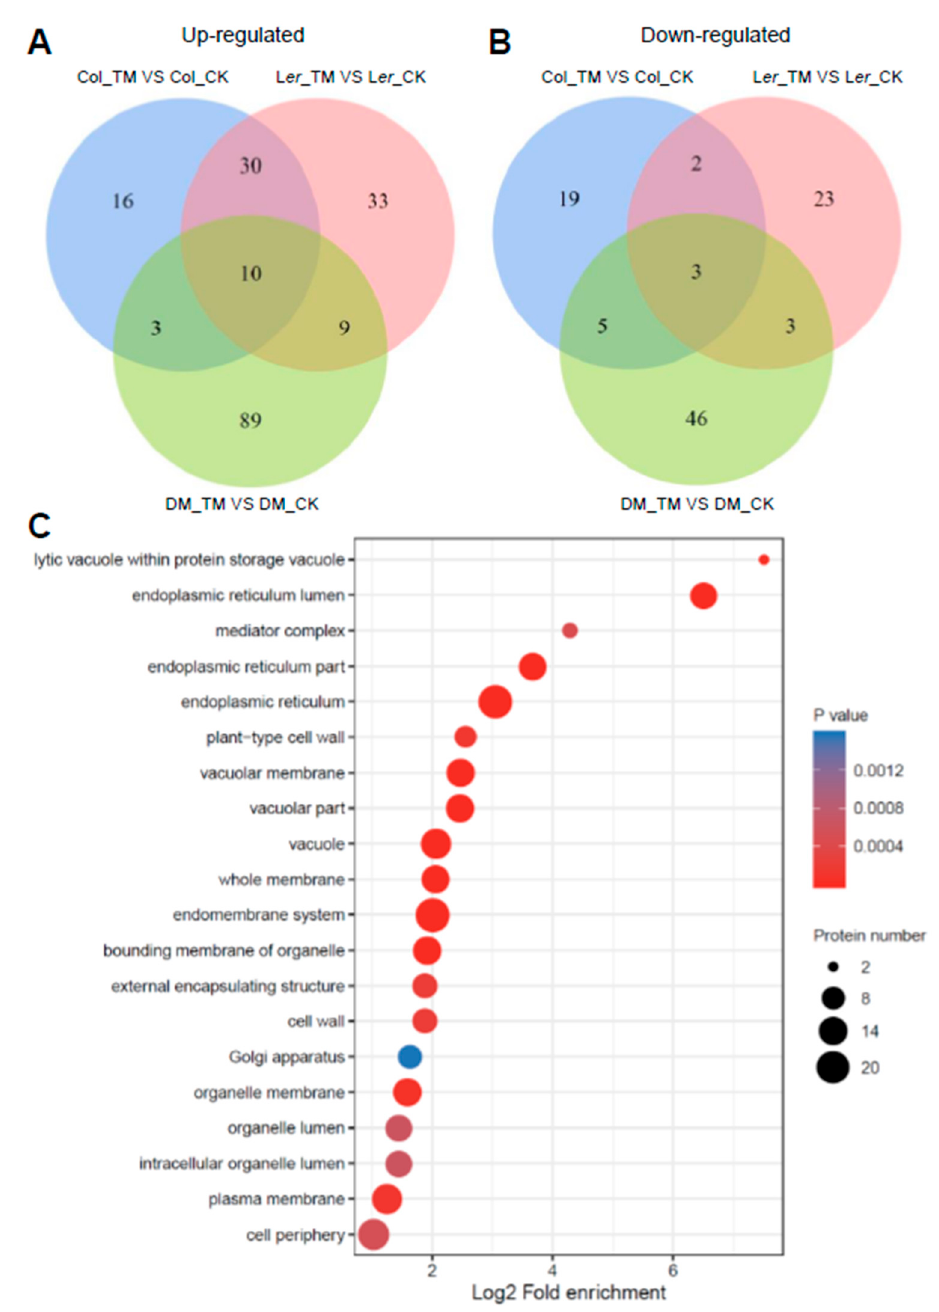
Figure 5. Commonly and specifically regulated proteins at the protein level by ER stress among Col, L er , and DM plants. ( A , B ) Venn diagrams showing the number of overlapping and non-overlapping proteins that were di ff erentially regulated among Col, L er , and DM plants. Criteria for di ff erential regulation were set as fold change > 1.3 for upregulation or < 0.7 for downregulation, p < 0.05; ( C ) Functional enrichment of cellular components for the proteins that are commonly upregulated by ER stress in both Col and L er plants.